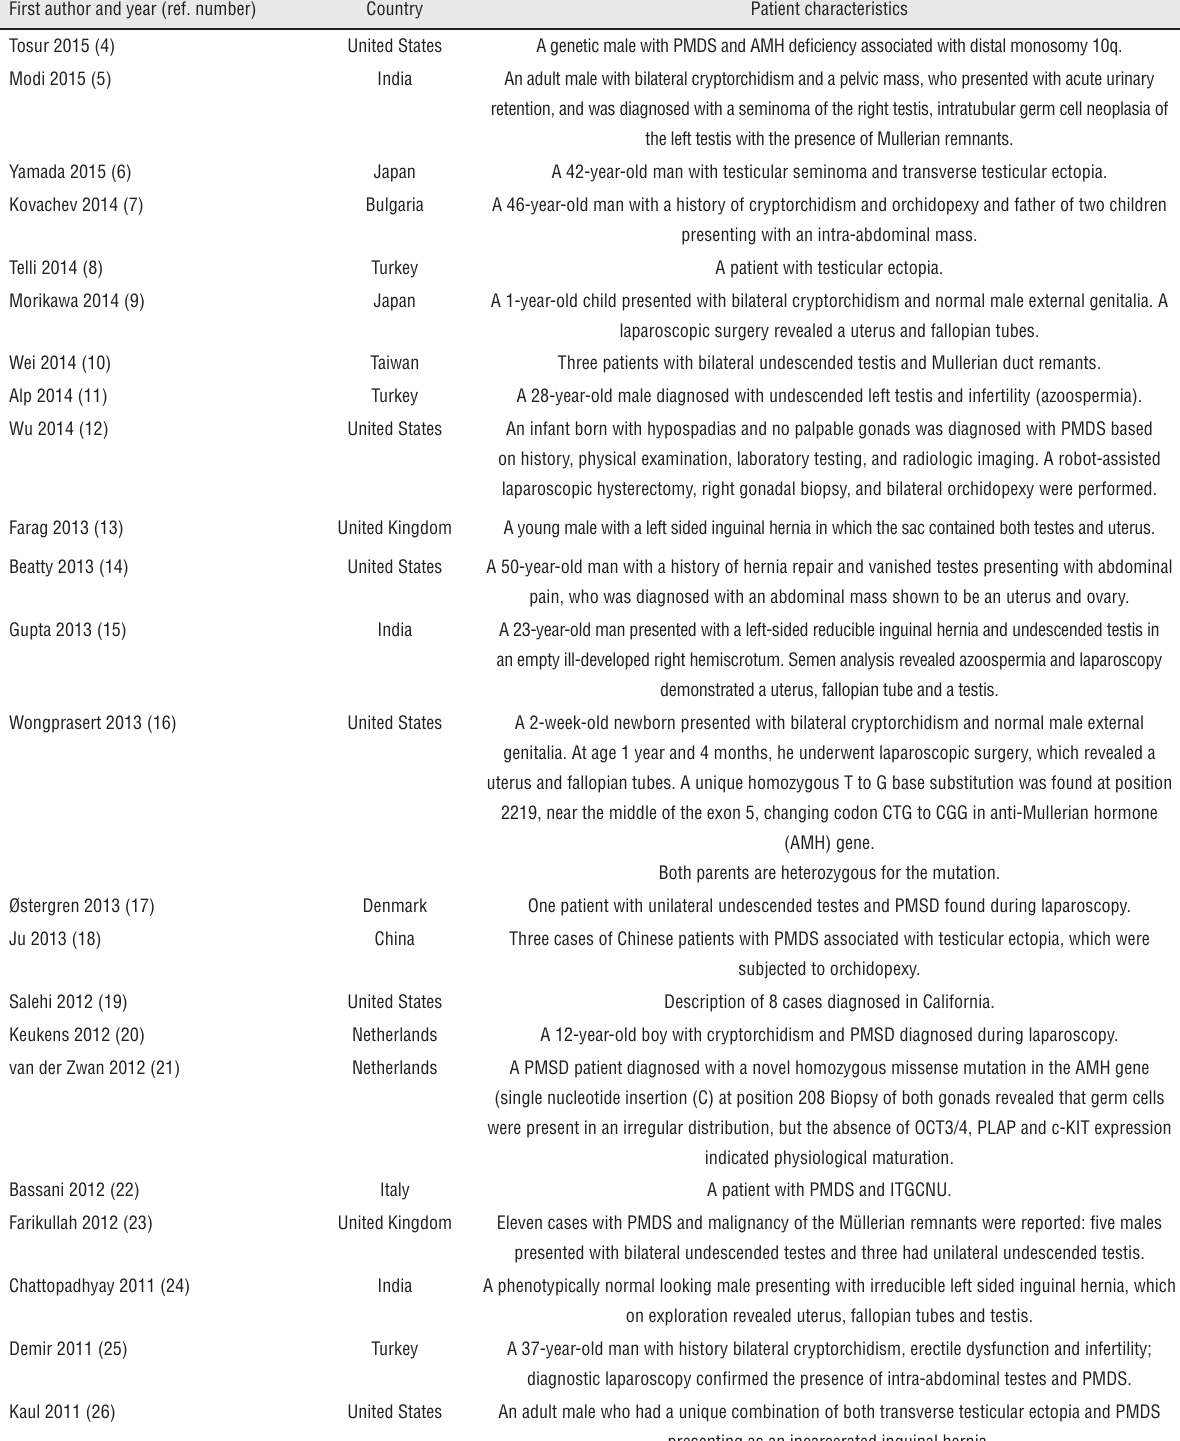
Table 1 - case reports of persistent Mullerian Duct syndrome (pMDs) in the last five